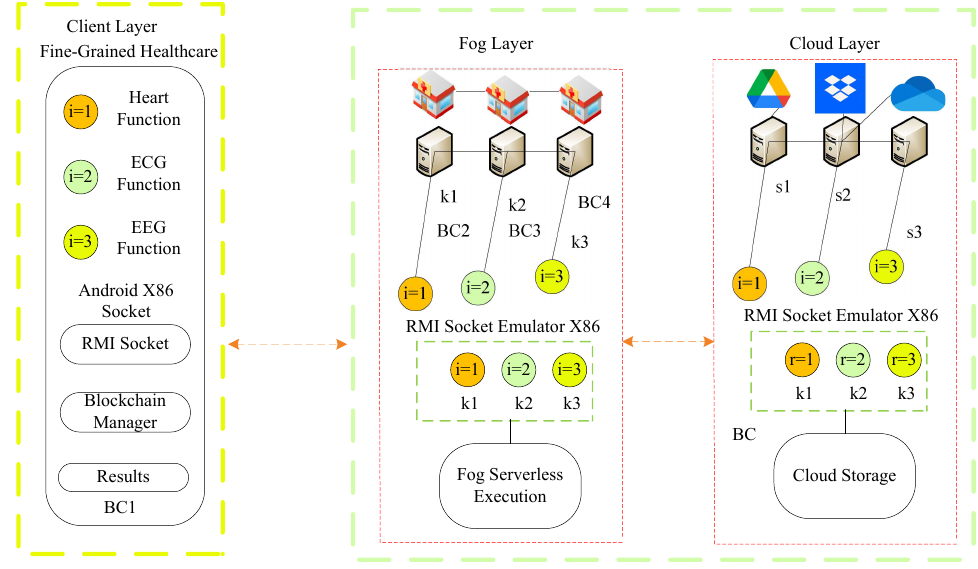
Figure 1. Blockchain RMI Socket-Enabled